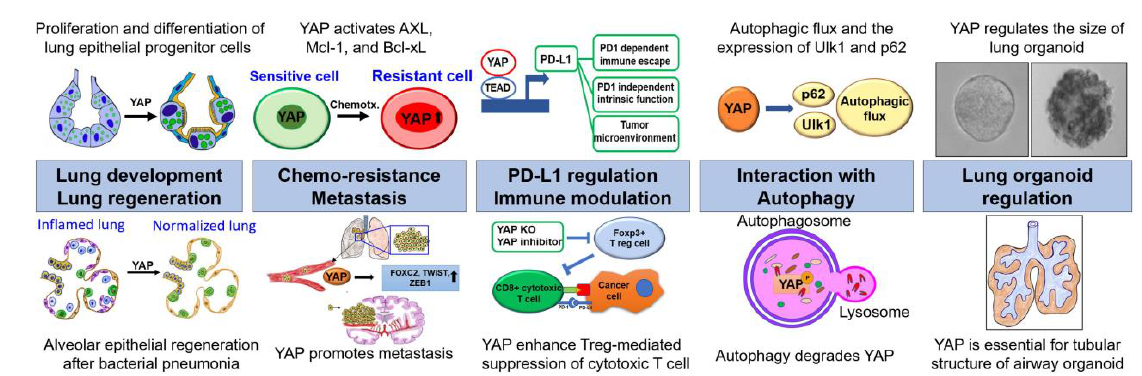
Figure 2. The crucial roles of YAP from chemoresistance and tumor immunity to autophagy and organoid. YAP is intimately involved in lung development and regeneration. In cancer, it promotes drug resistance by activating AXL, Mcl-1, and Bcl-xL. In addition, YAP induces the metastasis of cancer cells by increasing the expressions of FOXC2, TWIST, and ZEB1. It also directly regulates the transcription of PD-L1 and modulates the functions of several immune cell types. Furthermore, it regulates autophagic flux and the expression of several key autophagic factors, including p62 and Ulk1. Lastly, YAP plays a crucial role in regulating the size of lung organoids and developing the tubular structure of airway